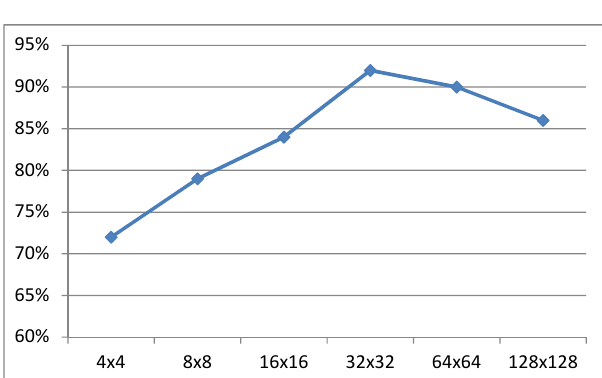
Figure 7. Classification rates as a function of block size in HOG